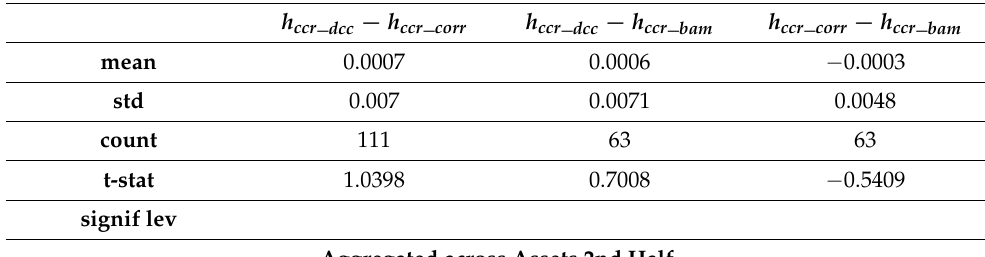
Table 5. Cont. Panel D. Aggregated across Assets 1st